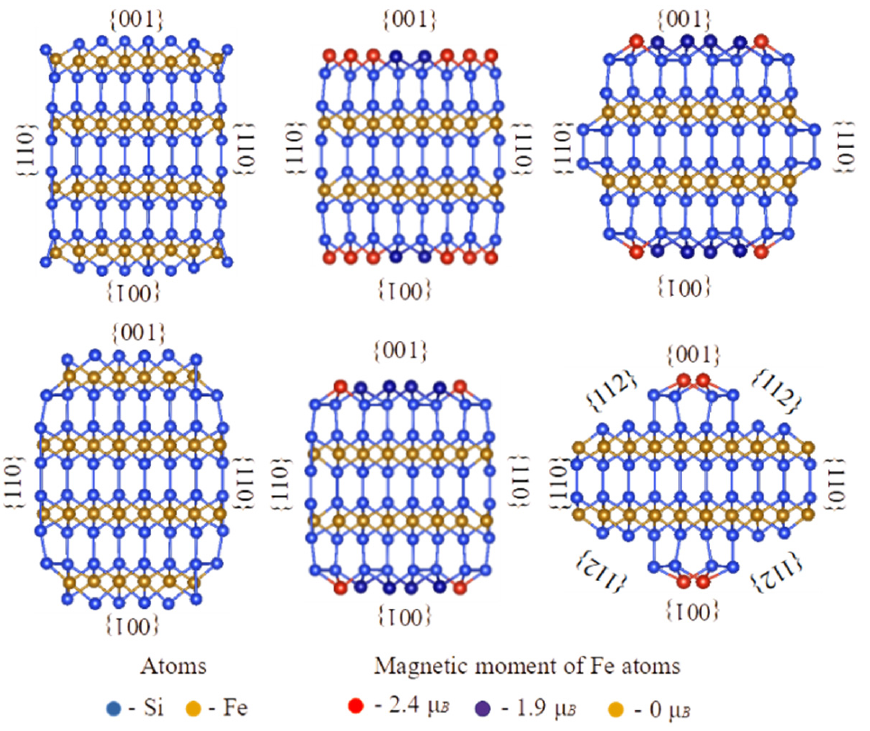
Figure 6. Cross sections of <110>-oriented α -FeSi 2 NWs with different morphologies indicating surface Fe atoms with magnetic moments. All facets are shown.